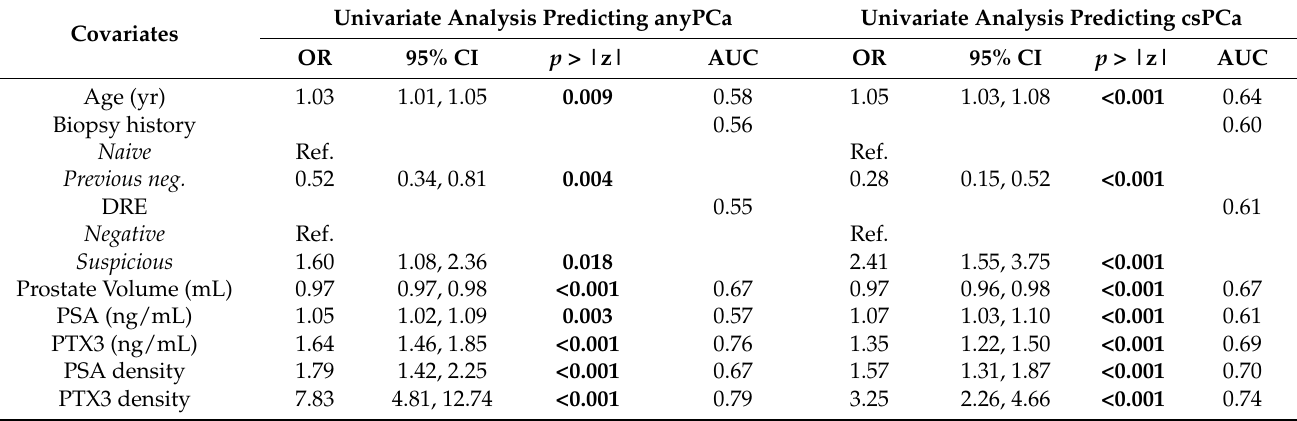
Table 2. Univariate logistic regression predicting anyPCa and csPCa.